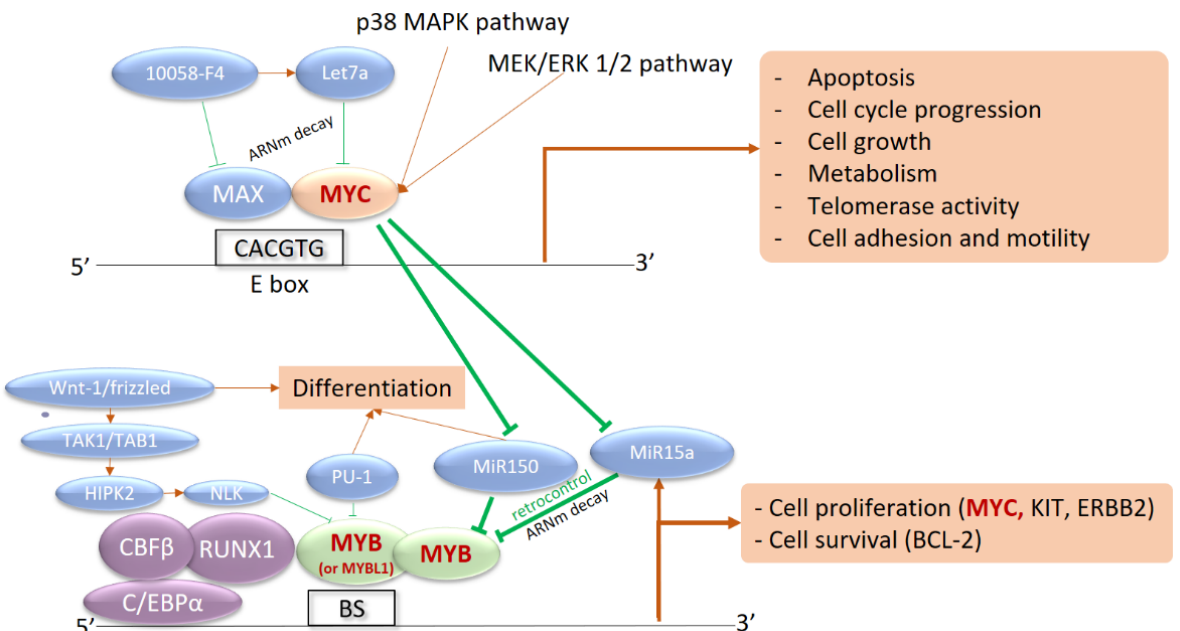
Figure 1. Interaction network between MYB, MYC, and their transcriptional targets. MYC is a strong transcriptional activator, dependent on the intracellular phosphorylation cascade signaling pathways of Mitogen-Activated Protein Kinases (MAPK) and Extracellular signal-Regulated Kinases (ERK) (p38 MAPK and MEK/ERK pathways 1 and 2). Activation of MYC induces the transcription of numerous target genes involved in proliferation, division, metabolism, and cell motility, as well as apoptosis. MYC also inhibits microRNAs (MiR150 and MiR15a) that are capable of silencing MYB expression in the basal state. Activation of MYC therefore induces activation of MYB, involved in the core binding factor (CBF) complex with CBFB, RUNX1, and CEBPA. MYB is also a transcriptional activator recognizing multiple nucleotide sequences, in a complex with CEBP. The targeted genes are involved in survival with BCL-2 and cell proliferation with c-KIT, c-ERBB2, and especially MYC. This results in an activation loop between the two transcriptional activators: BS, MYB Binding Site with MYB Recognition Element.